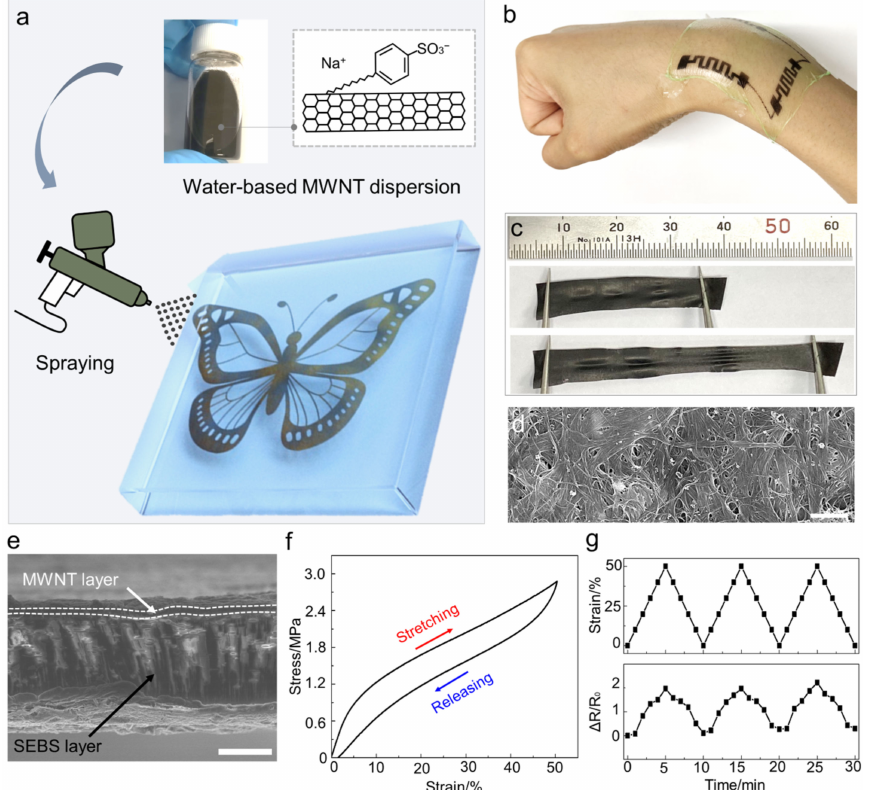
Figure 1. The morphology and characteristics of MWNT/SEBS bilayer-based electrochemical har- vester. ( a ) Schematic illustration of fabrication process based on the sequential spray-coating method. A MWNT/SEBS bilayer was formed by sequentially coating MWNT dispersion and SEBS solution. (Inset) The optical image of MWNT dispersion with sodium dodecylbenzene sulfonate; ( b ) The optical image of the patterned MWTN/SEBS bilayer was attached to the human wrist to demonstrate the utility of the wearable device; ( c ) The optical image of MWNT/SEBS bilayer for 0% and 50% strain; ( d ) SEM image of MWNT/SEBS bilayer in which MWNT are physically entangled with each other (scale bar: 500 nm); ( e ) The cross-sectional SEM image of MWNT/SEBS bilayer (scale bar: 10 um); ( f ) Strain–stress curve of MWNT/SEBS bilayer stretched to 50% strain; ( g ) The strain and resistance ratio value of the MWNT/SEBS bilayer while reversibly stretching to 50%